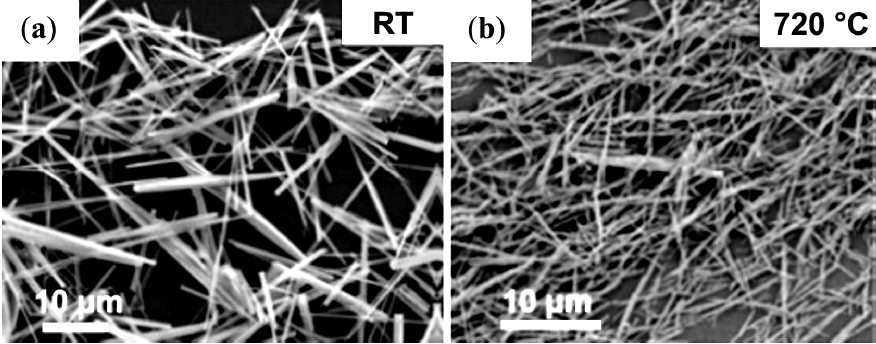
Figure 14. Scanning electron microscope (SEM) images for: ( a ) as-synthesized CoFe suspension after coprecipitation in a microemulsion; and ( b ) CoFe Reprinted with permission from [39]. Copyright 2005